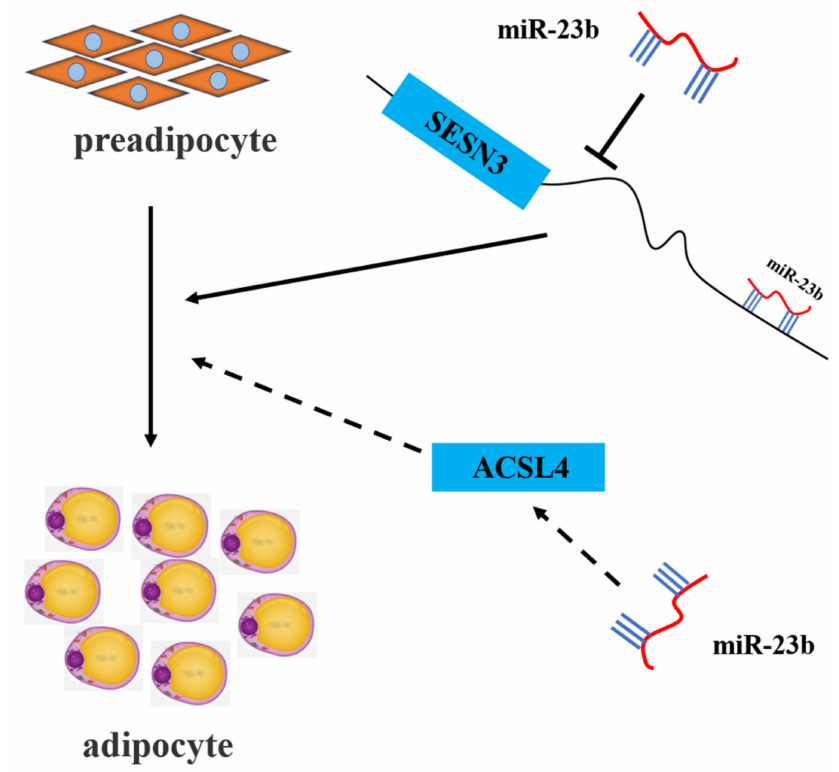
Figure 7. Schematic illustration of the mechanism of miR-23b regulating fat metabolism in